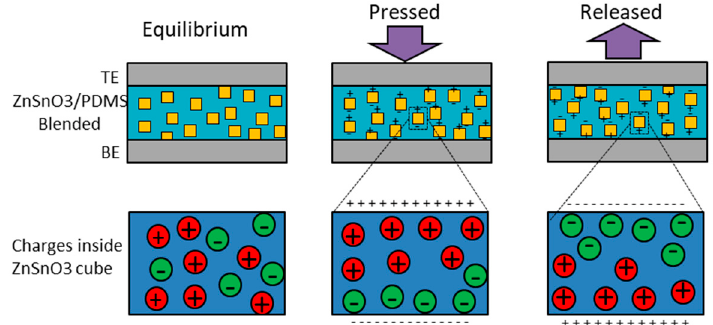
Figure 5. Working mechanism of the ZnSnO 3 :PDMS-based nanogenerator.